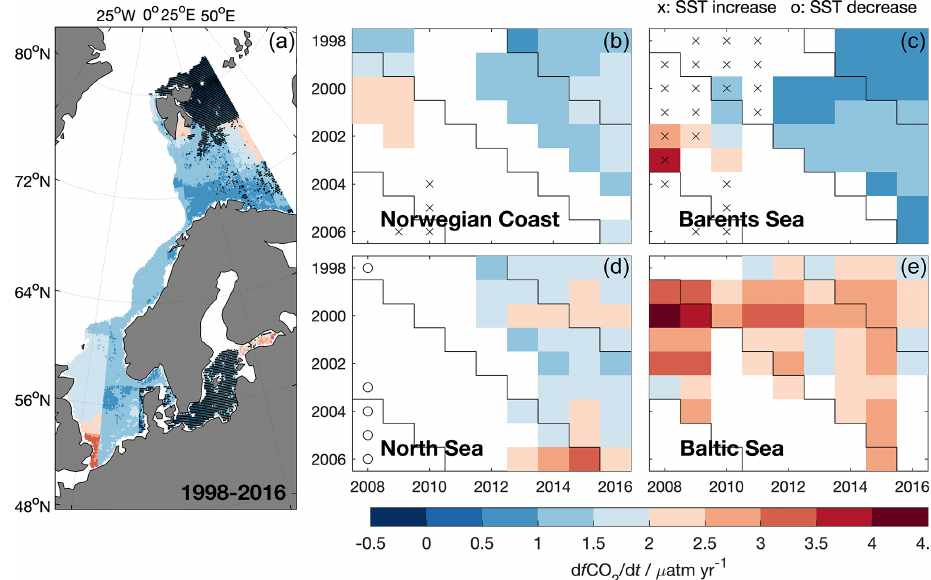
Figure 9. The trend in surface ocean f CO 2 estimated from deseasonalized f CO 2 . Panel (a) shows the spatial distribution of the trend over the time period from 1998 to 2016. Grid boxes without a significant trend are denoted with a black dot. Panels (b) – (e) show the trends in different time periods in four regions, from the various years on the y axis to the various years on the x axis. Non-significant trends were left blank. Significant trends in sea surface temperature are indicated with crosses/circles. The color bar is centered on the approximate annual f CO 2 rise in the atmosphere (2µatmyr − 1 ).